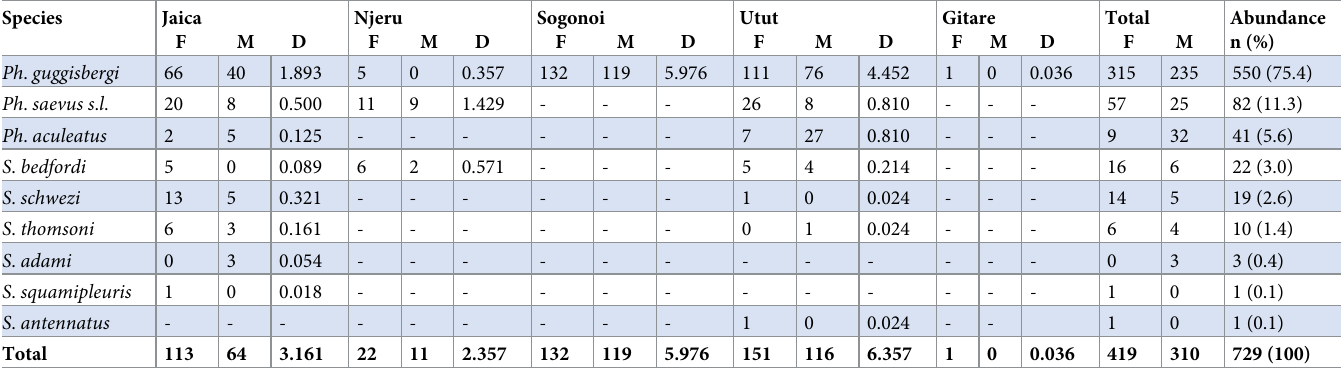
Table 1. Sandfly density, relative abundance (%) and sex ratios in Gilgil. Species Jaica